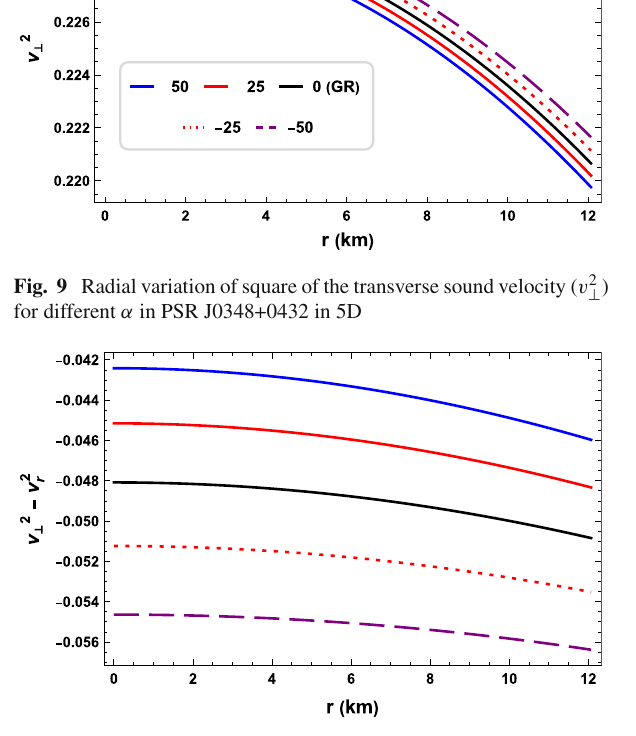
Fig. 10 Radial variation of v 2 ⊥ − v 2 r in PSR J0348+0432 for α equals to 50, 25, 0, − 25, − 50 (in order of top to bottom) in 5D